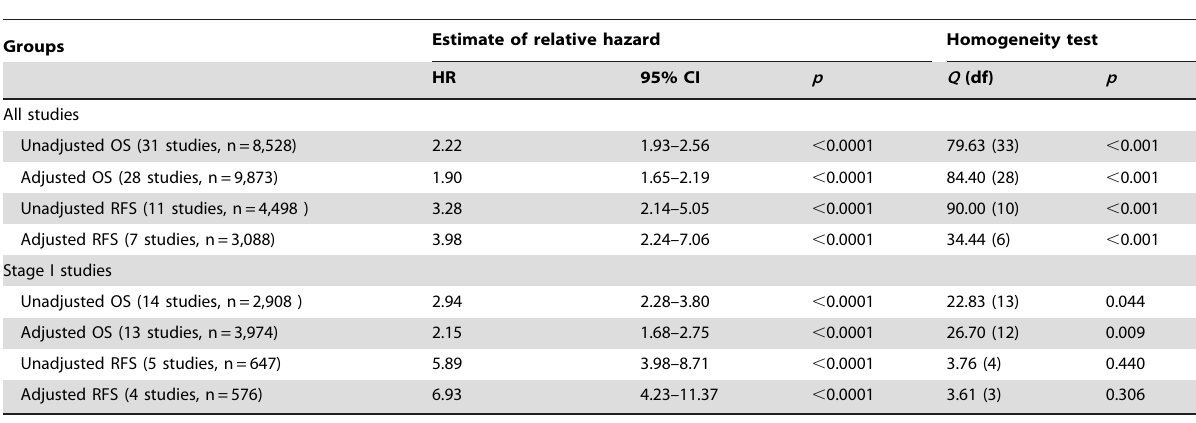
Table 2. Results of meta-analysis of blood vessel invasion and prognosis in